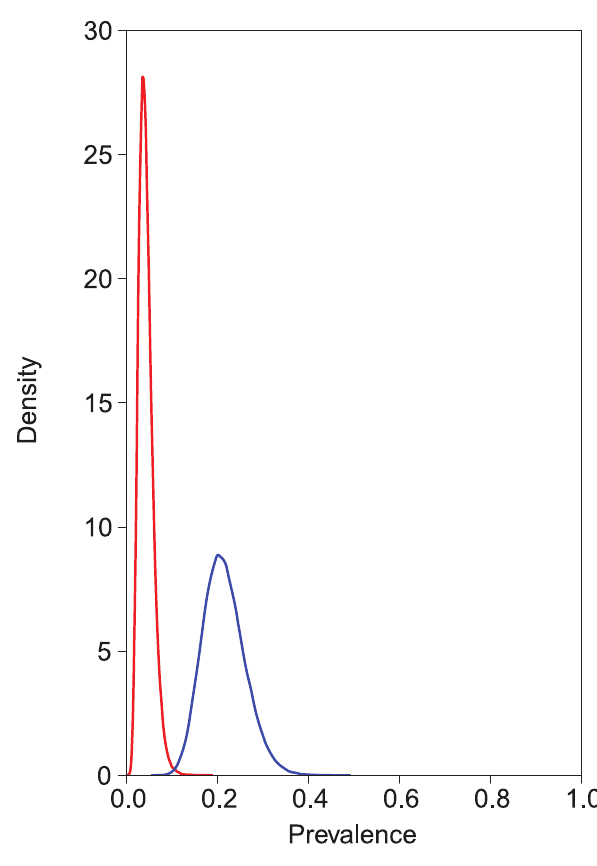
Figure 2. Effect of Taenia co-infection on prevalence of E. granulosus. Using a Bayesian latent-class model, prevalence of E. granulosus in Taenia test-negative dogs was estimated at 4.1% (95% credible intervals 1.9–8%), and in Taenia test-positive dogs was estimated at 21.1% (95% credible intervals 5.1–56.9%). Taenia co- infection was found to be a significant covariate with E. granulosus infection (odds ratio 6.32, 95% credible intervals 2.8–15.2). In the figure the posterior distributions of the prevalence of E. granulosus with (blue) and without (red) Taenia co-infection are shown.